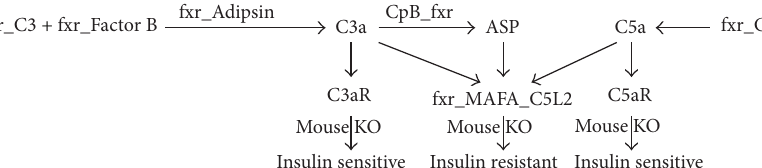
Figure 3: Complement alternative activation pathway with corresponding receptors and mouse knockout phenotypes.